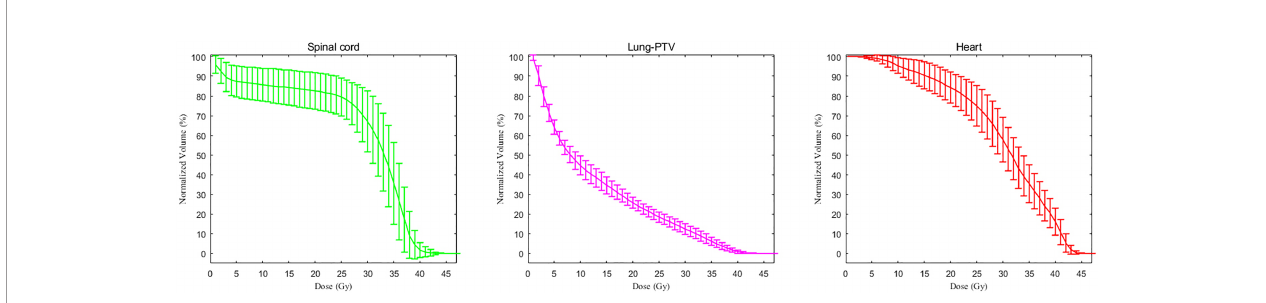
FIGURE 2 | The dose-volume histogram parameters of normal tissue and organs. The dose-volume histogram curve comprises the average values, and the upper and lower ranges represent the standard